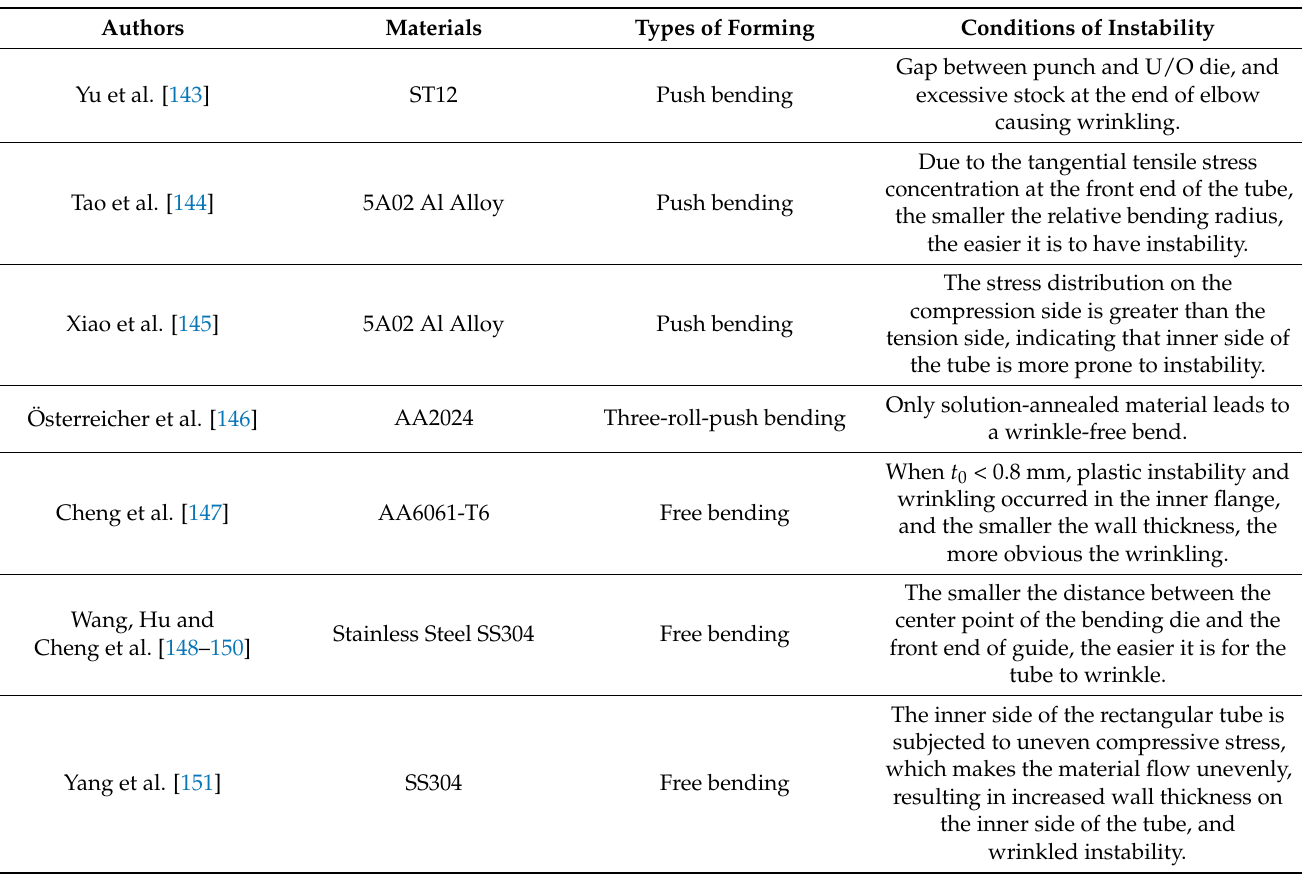
Table 4. Summary of deformation instability during bending tube process.